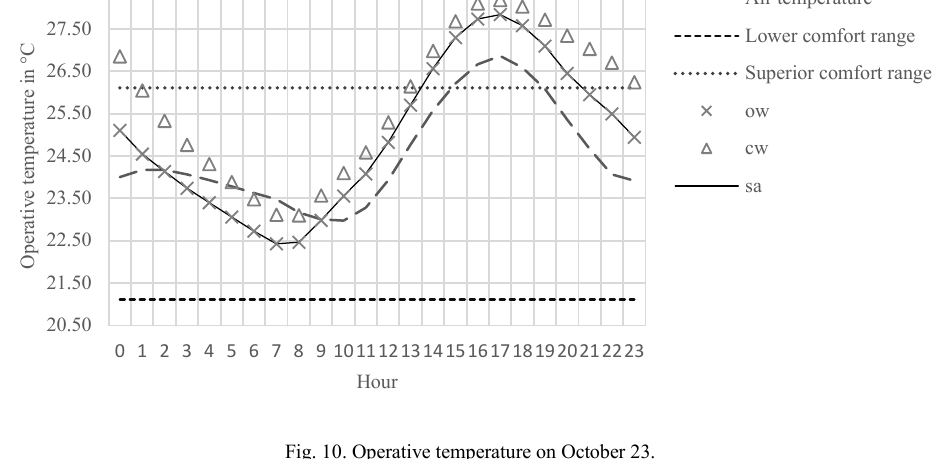
Fig. 10. Operative temperature on October